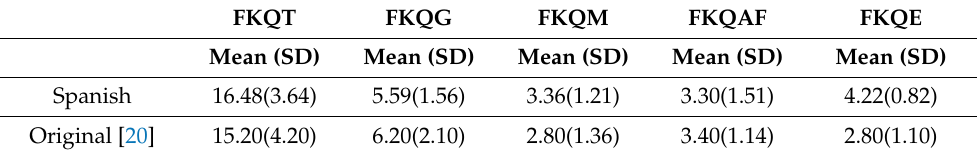
Table 7. Average scores obtained in each dimension of the FKQ in Spanish and in the original study. FKQT FKQG